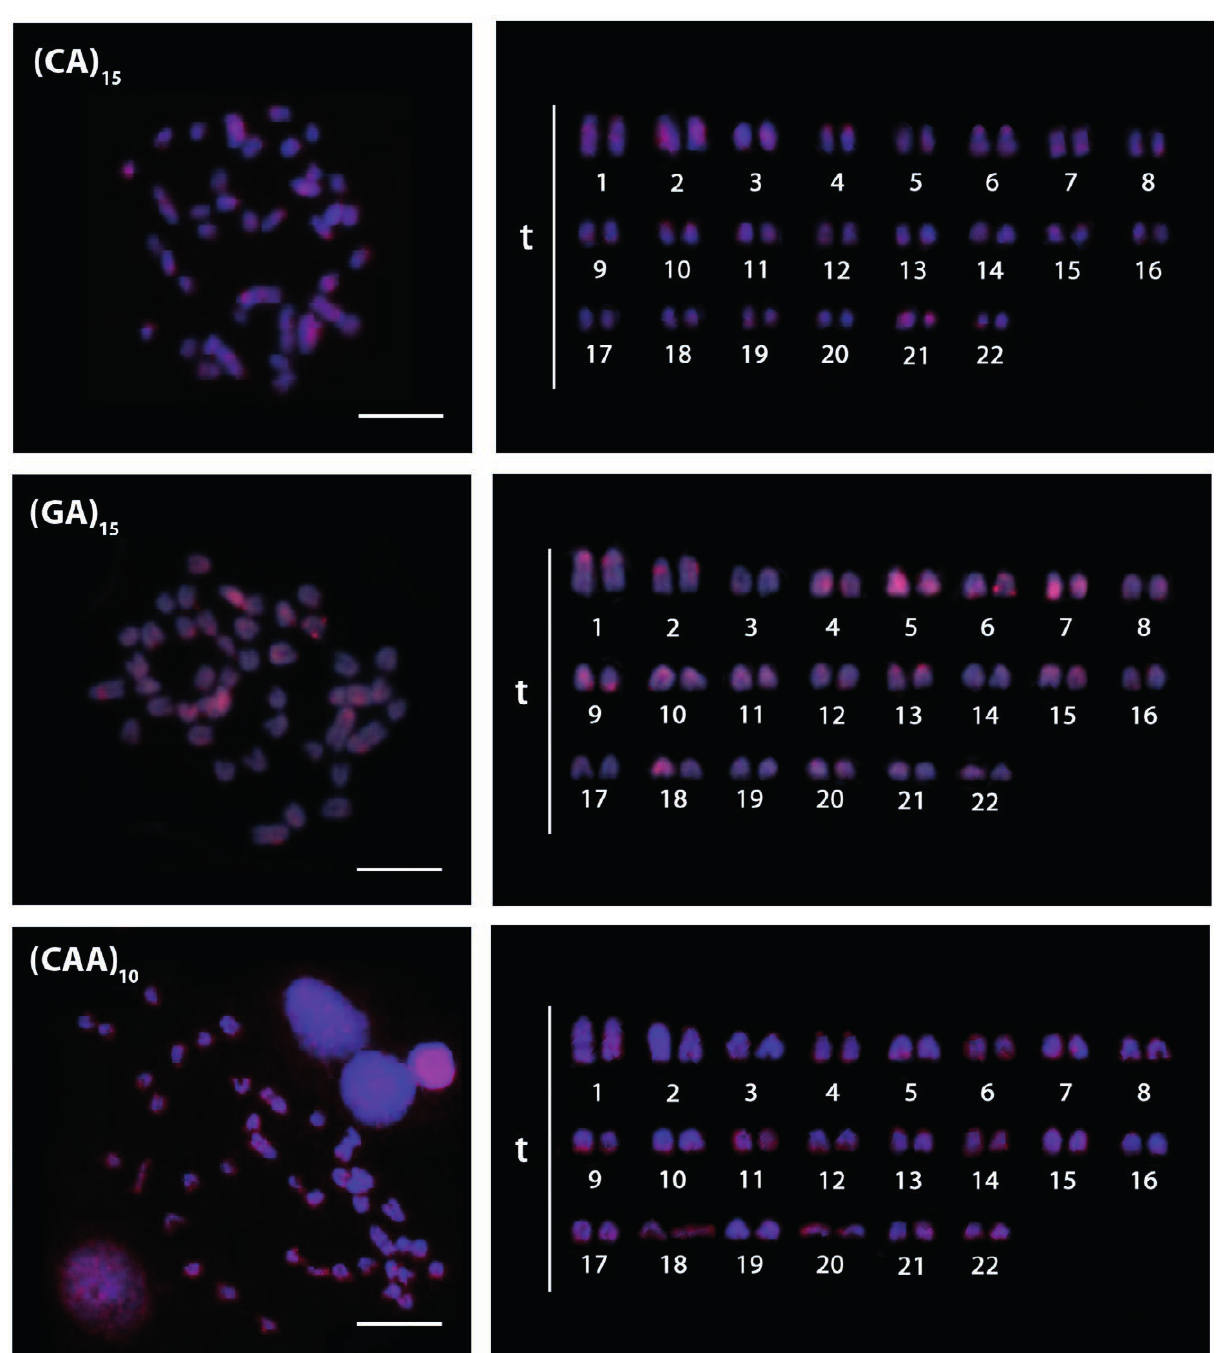
Figure 3. Chromosomal mapping of di- and tri-nucleotide microsatellites in the chromosomes of Rhinecanthus aculeatus by fluorescence in situ hybridization. The general distribution pattern of (CA) 15 , (GA) 15 and (CAA) 10 microsatellites is mainly diffuse, with the occurrence of few conspicuous clusters in some centromeric and chromosome arm regions. Bar = 5